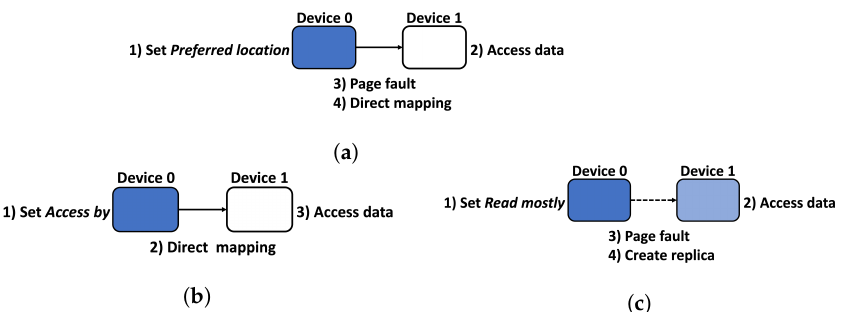
Figure 1. Operation method according to the type of memory advise: ( a ) Data set as Preferred location are directly mapped when accessed from other devices; ( b ) If data are set to Access by , a direct mapping is created with a specific device; ( c ) When another device accesses data set to Read mostly, a replica is created on the accessed